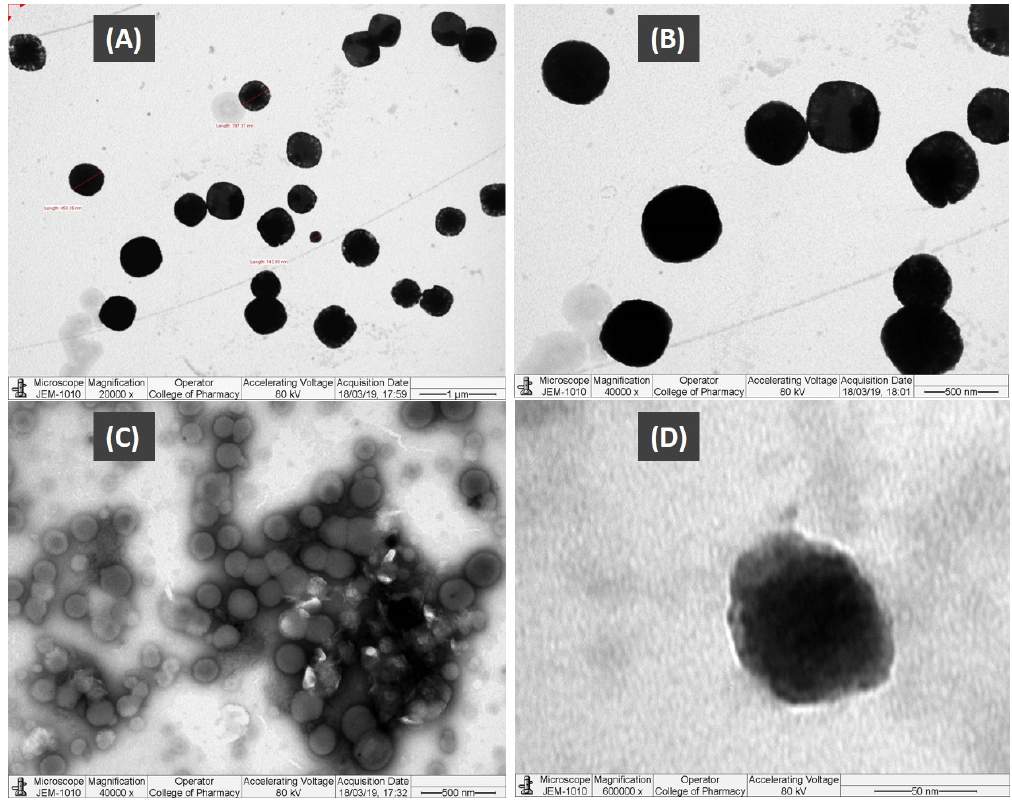
Figure 2. TEM micrographs of the APG - loaded Bio-SNEDDS. ( A – D ) Images at different magnifications.